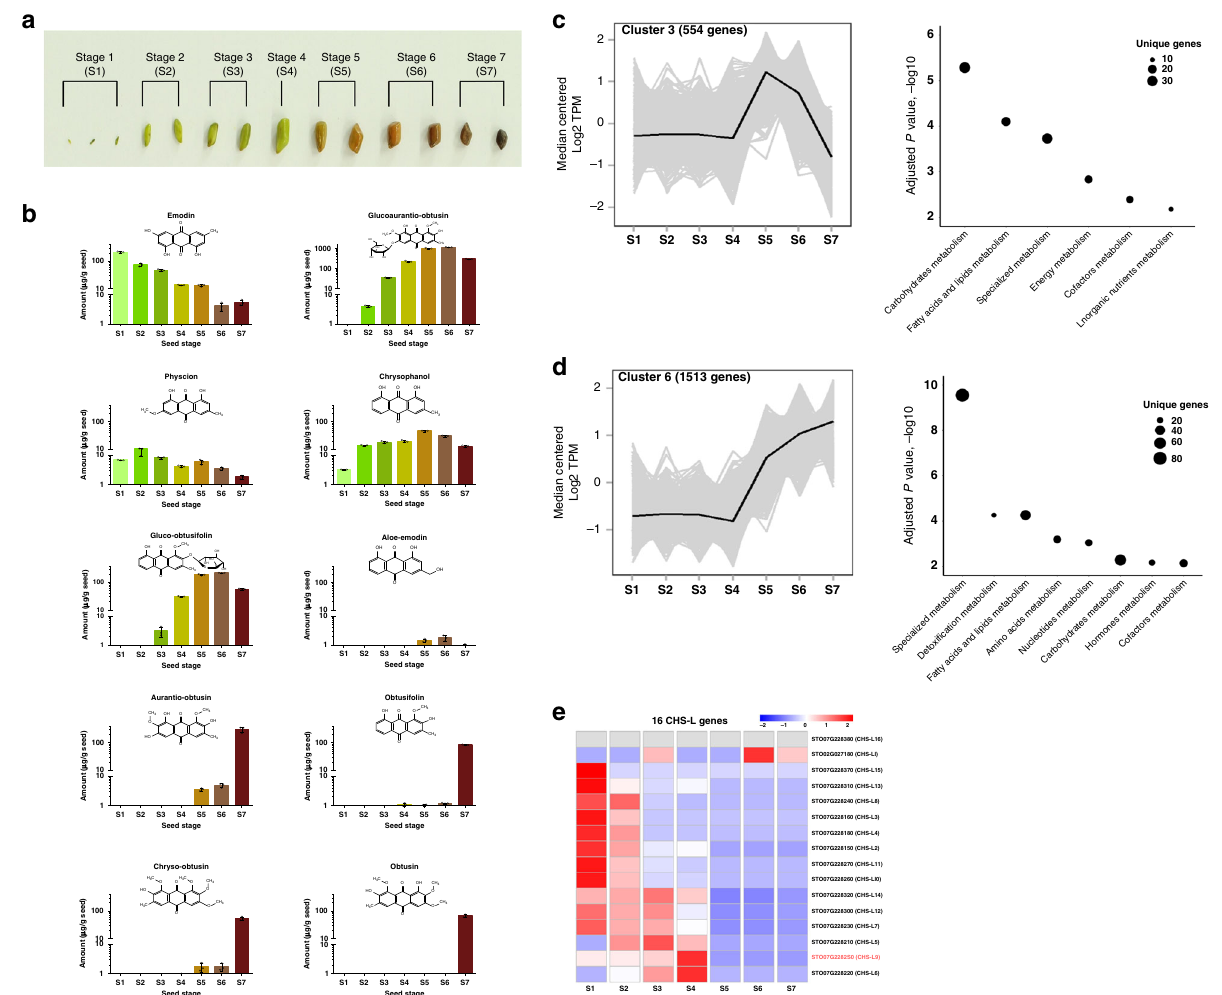
Fig. 2 Analysis of anthraquinone contents and CHS-L gene expression during S. tora seed development. a Developmental progression of S. tora seeds (Stage 1 – Stage 7). b Concentrations of ten anthraquinones during the seven developmental stages of S . tora seeds (mean ± SD, n = 3). Dots represent individual values. c , d Scaled transcript expression pro fi les (in transcripts per million, TPM) of cluster 3 (554 genes) and cluster 6 (1,513 genes) during seed development and enriched metabolic domains within these two clusters. e Expression analysis of CHS-L genes during seed development. Heatmap represents normalized transcripts per million (TPM) from two biological replicates. S1 – S7 represents the seed-development stages of S. tora . The source data underlying Fig. 2b are provided as a Source Data fi